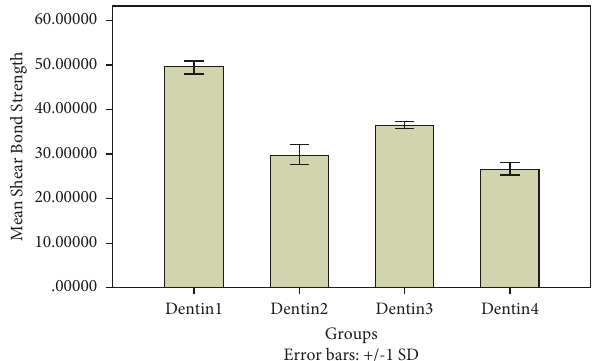
Figure 4: Comparison of mean shear bond strengths of dentin groups subjected to different bonding